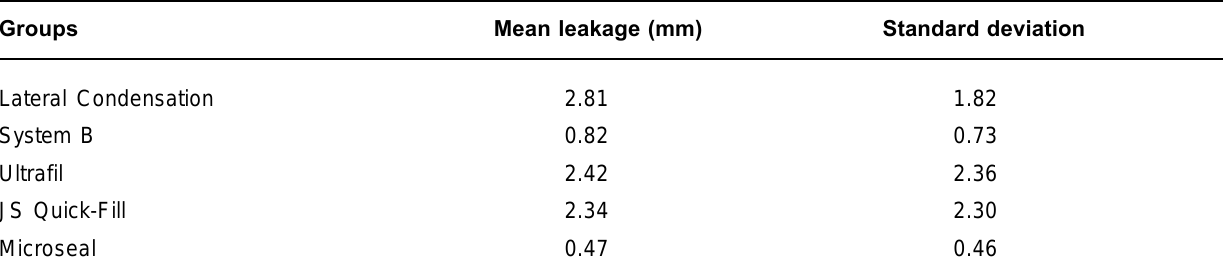
TABLE 1- Mean apical leakage and standard deviation for the experimental